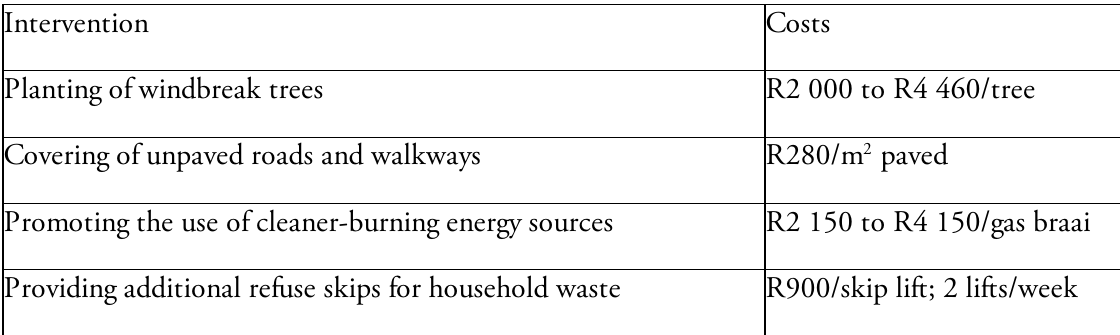
Table 9: Costs of the PM10 reduction interventions